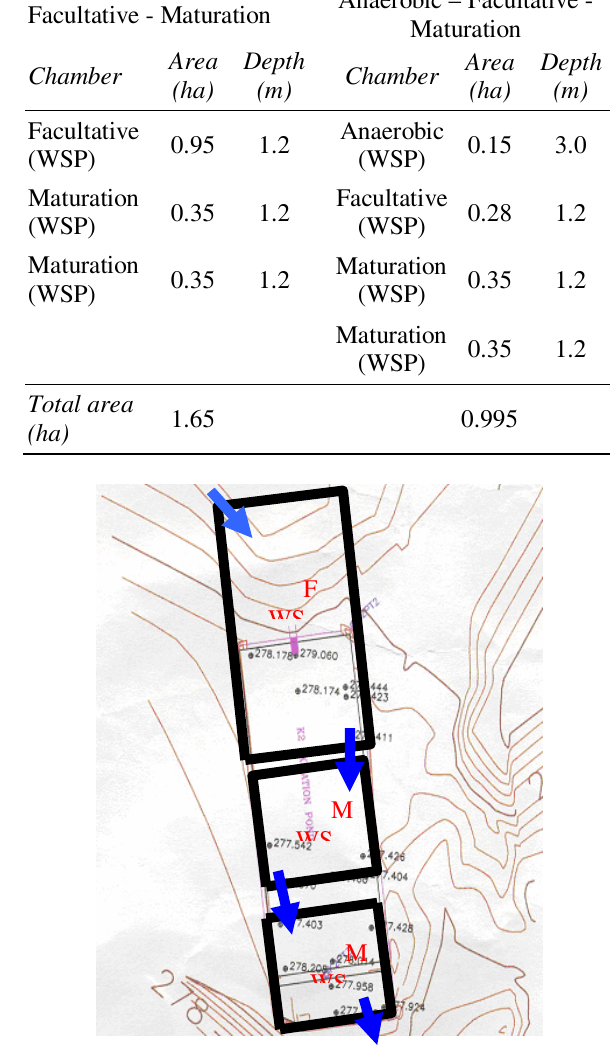
Figure 4: Layout of the K2 pond with FM system